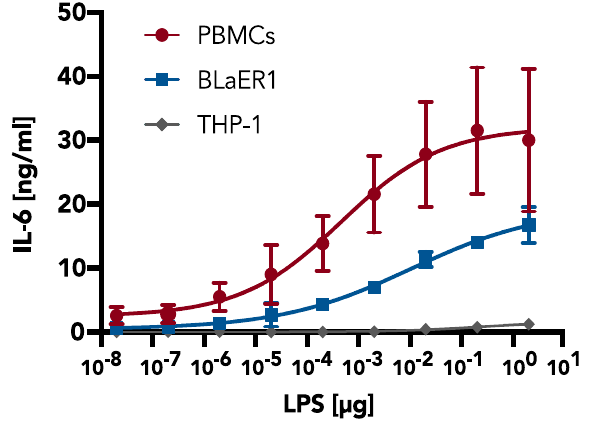
Figure 1. BLaER1 but not THP-1 monocytes model the LPS response of human PBMCs. After stimulation of human PBMCs, BLaER1 monocytes, and THP-1 monocytes for 16 h with LPS, IL-6 in the supernatant was measured by ELISA. Values correspond to the mean ± SD of n = 2 independent experiments (for BLaER1 and THP-1) or n = 5 donors (for